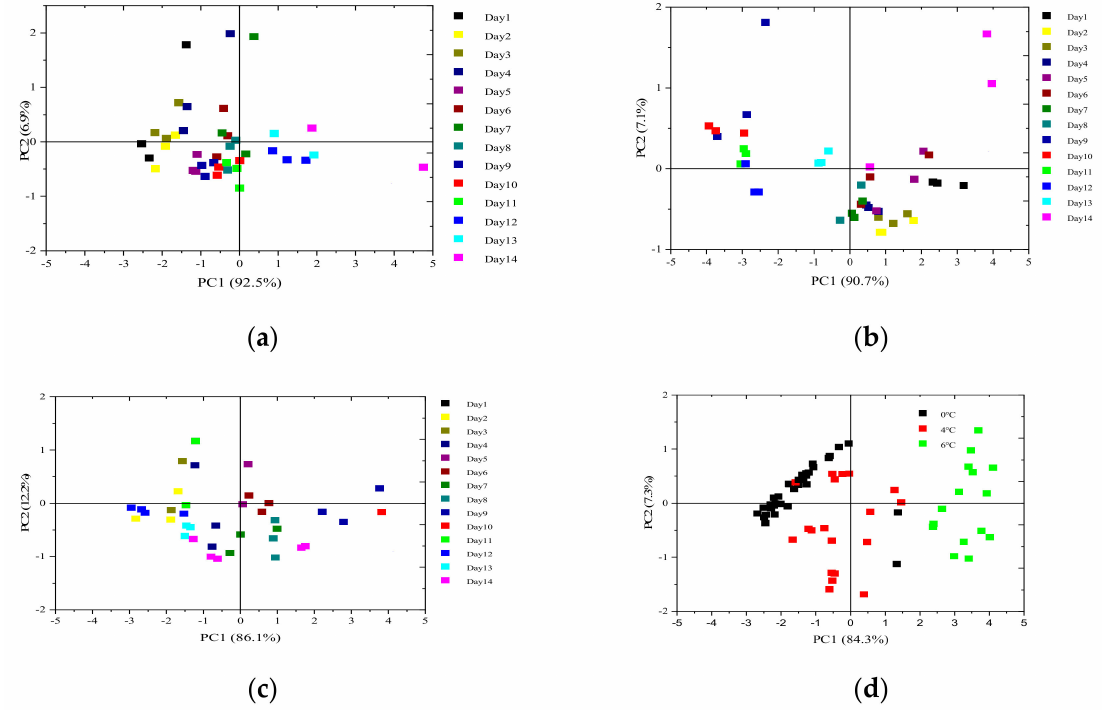
Figure 5. Principal component analysis (PCA) analysis results of the number of storage days. ( a ) PCA scores plot of salmon samples. at 0 ◦ C; ( b ) PCA scores plot of salmon samples at 4 ◦ C; ( c ) PCA scores plot of salmon samples at 6 ◦ C; ( d ) PCA scores plot of the total salmon samples at 0 ◦ C, 4 ◦ C, and 6 ◦